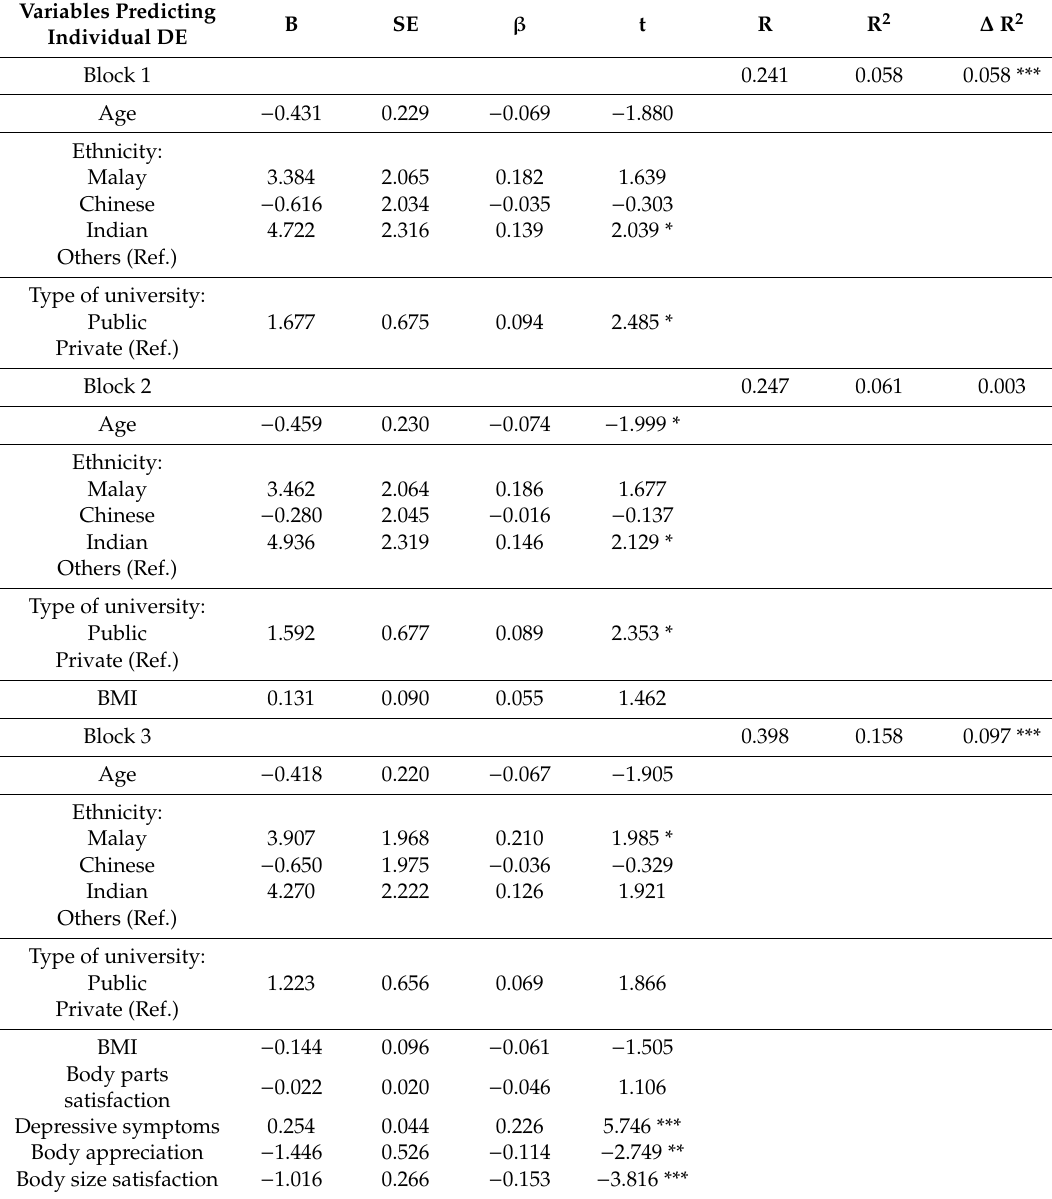
Table 6. Hierarchical multiple regression analyses for individual prediction of disordered eating (EAT-26) from body mass index, socio-demographic, and personal variables in overall model ( n = 716). Variables